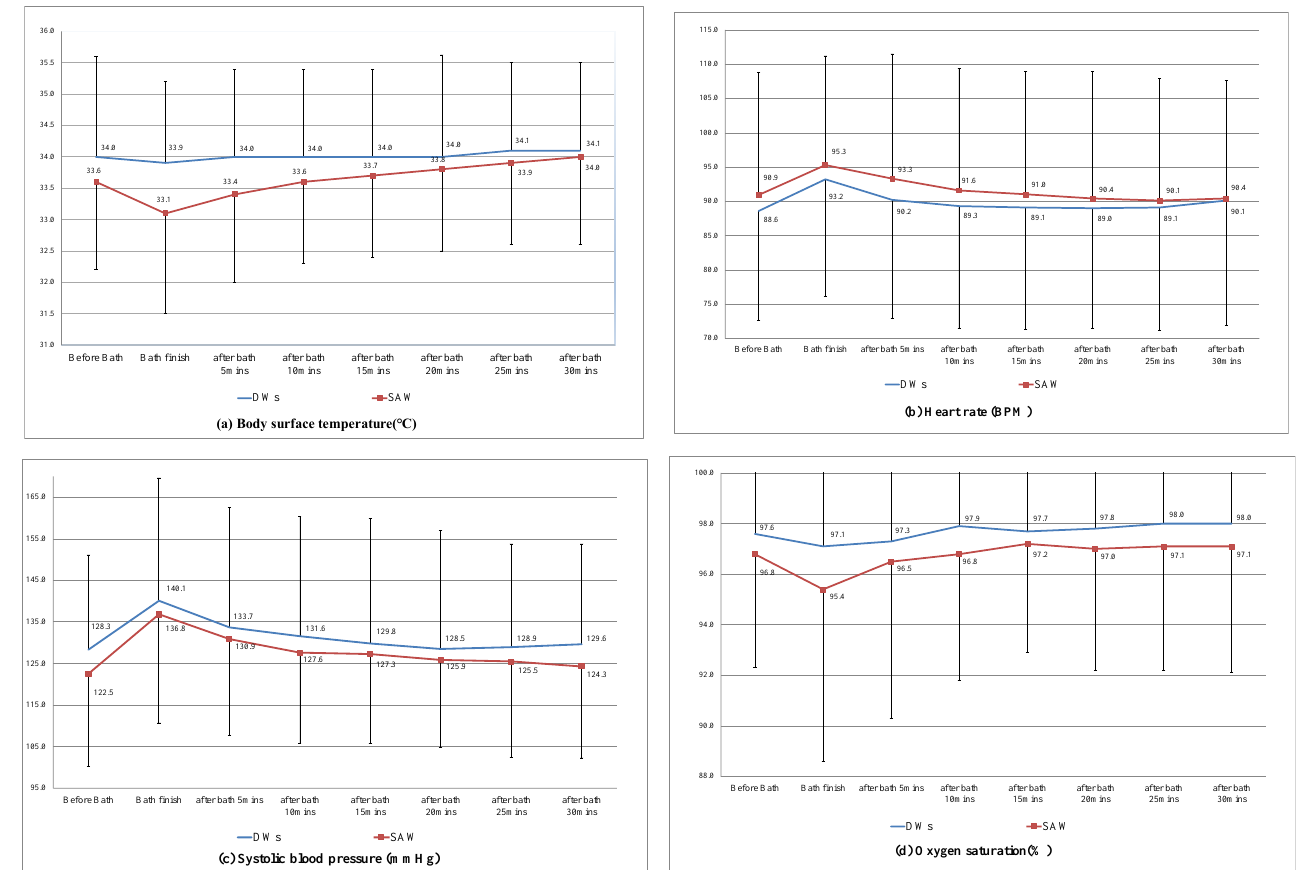
Figure 2. Vital sign trends for the two groups: ( a ) body surface temperature, ( b ) heart rate, ( c ) systolic blood pressure, and ( d ) oxygen saturation. Table 3. Staff satisfaction related to the bed-bathing methods ( n =